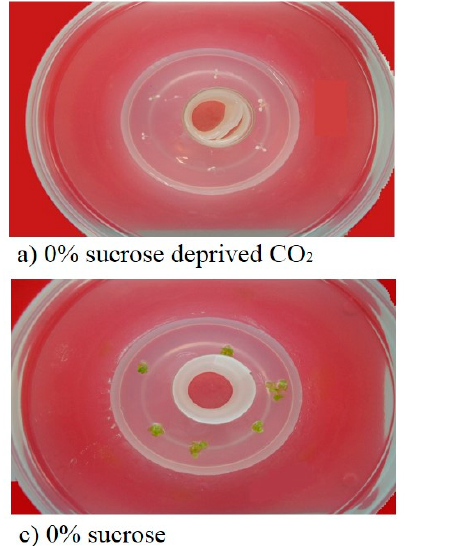
Figure 3. Effect of CO 2 removal on the growth of Arabidopsis seedlings, ( a ) FW shoot and ( b ) FW root in medium with 3% sucrose and without sucrose : *, p ≤ 0.05; **, p ≤ 0.01; and ***, p ≤ 0.001.